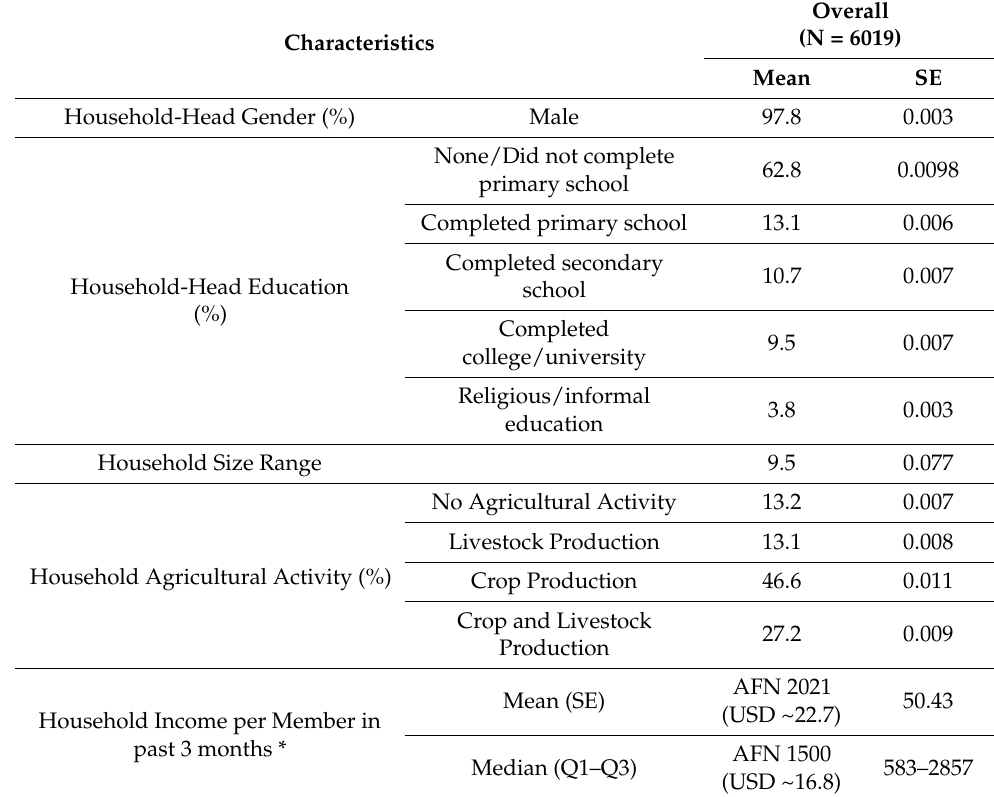
Table 2. Weighted characteristics of the